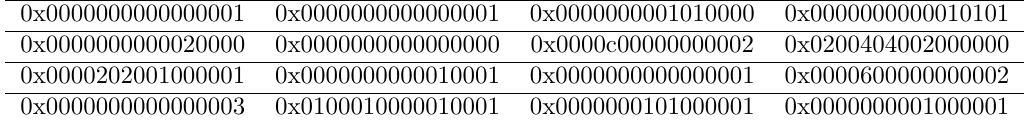
Table 3: Output bits of the linear characteristic with input s 9